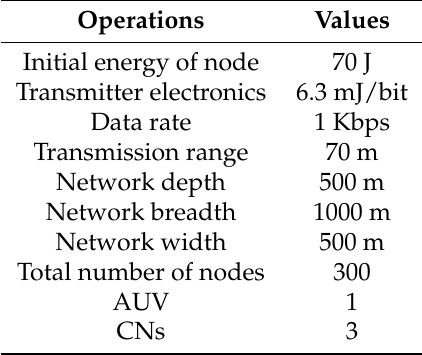
Table 3. Simulation